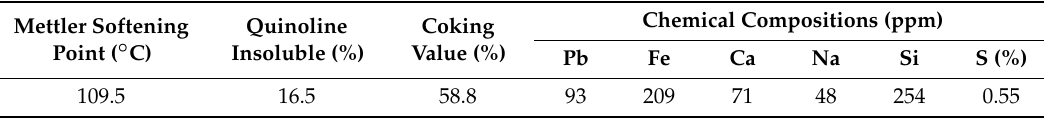
Table 3. Physical properties and chemical compositions of the applied pitch. Mettler